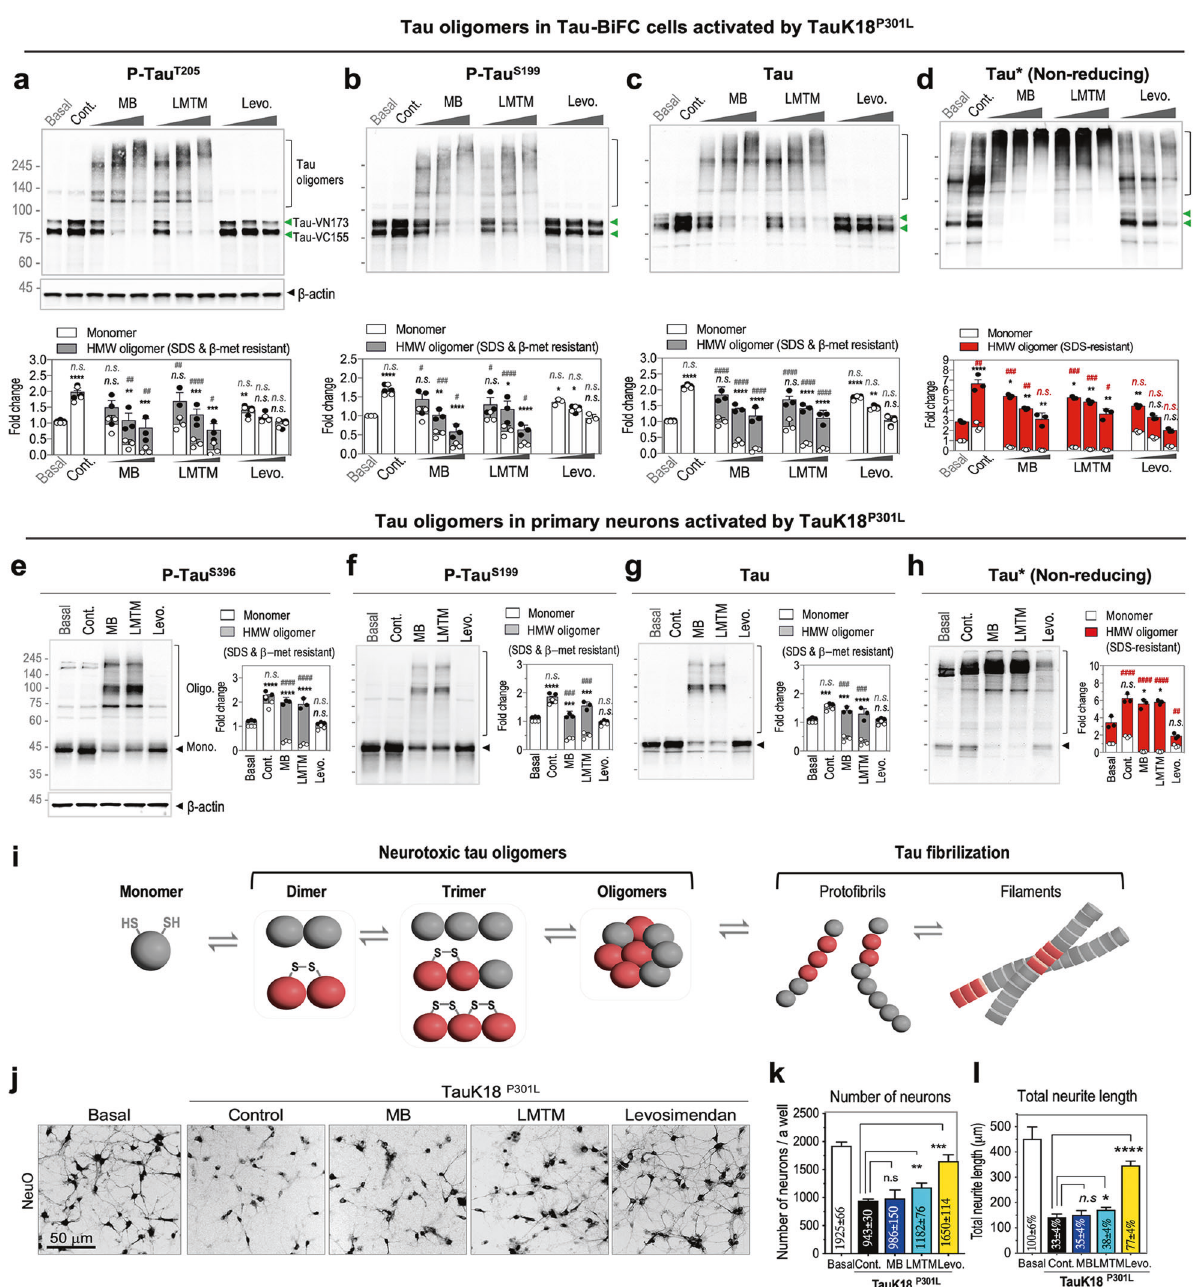
Fig. 2 Levosimendan inhibits tau oligomerization in tau-BiFC and primary neuronal cells, while MB and LMTM increase tau oligomerization. a – c Immunoblot analysis of total and phospho-tau. For immunoblot analysis, tau-BiFC cells were treated with MB, LMTM (0.5, 1.5, 5 µM), or levosimendan (5, 15, 45 µM) in the presence of tauK18 P301L . Green arrows indicate monomer bands of hTau-VN173 and hTau- VC155. Bands above 100 kDa indicate tau oligomers. Relative amounts of monomeric tau (white bars) and oligomeric tau (gray bars) were quanti fi ed by ImageJ. β -Actin was used as a loading control. All data were normalized to β -actin. d Immunoblot analysis of total tau under nonreducing conditions. Relative amounts of monomeric tau (white bars) and oligomeric tau (red bars) were quanti fi ed by ImageJ. e – g Immunoblot analysis of total and phospho-tau in the lysates of primary neurons. Relative amounts of monomeric and oligomeric tau were quanti fi ed by ImageJ. β -Actin was used as a loading control. All data were normalized to β -actin. h Immunoblot analysis of total tau under nonreducing conditions. a – h Data represent the mean ± S.D. of three independent experiments. Two-way ANOVA with Dunnett ’ s multiple- comparisons test was performed; *p < 0.05 , **p < 0.01 , ***p < 0.001 , ****p < 0.0001, compared with the level of monomer in basal. # p < 0.05, ## p < 0.01, ### p < 0.001, #### p < 0.0001, compared with the level of oligomers in basal. n.s. nonsigni fi cant. i Schematic diagram of the tau aggregation process. j Representative images of primary hippocampal neurons treated with MB, LMTM, or levosimendan. On Day 10 in vitro, hippocampal neurons were treated with MB, LMTM (3 µM), or Levosimendan (10 µM) in the presence of TauK18 P301 . After 48 h, hippocampal neurons were stained with NeuO, a live-neuron selective probe, and imaged by using Operetta ® . Scale bar, 50 µm. Quanti fi cation of the number of NeuO-stained neurons ( k ) and total neurite lengths ( l ). The number of neurons and total lengths of neurites were quanti fi ed by Harmony 3.1 software. Error bars represent the standard deviation of four replicate experiments. One-way ANOVA with Dunnett ’ s multiple- comparisons test was performed; *p < 0.05 , **p < 0.01 , ***p < 0.001 , ****p < 0.0001, compared with the